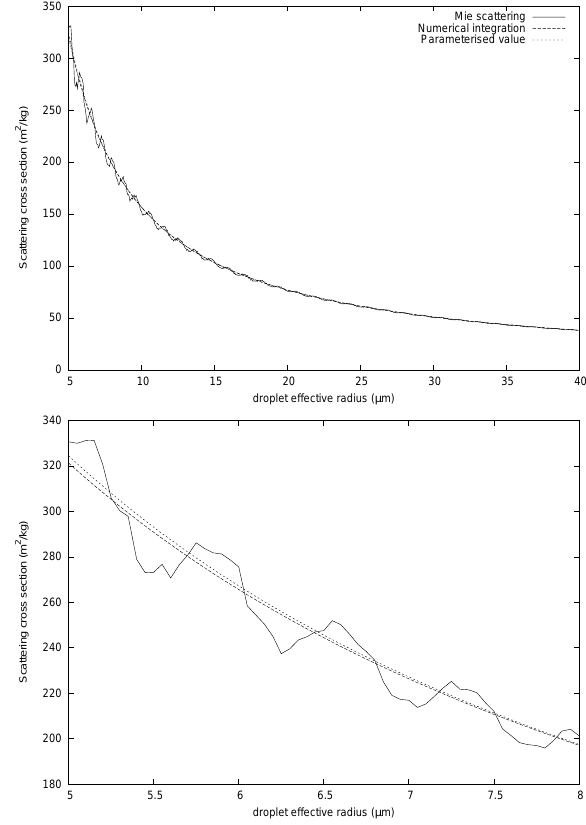
Fig. 3. Plot of scattering cross section for fixed radius droplets (solid line), numerically integrated over the droplet radius distri- bution (dashes), and iGen ’s simplified model (dots). For clarity, a magnified section is shown in the lower